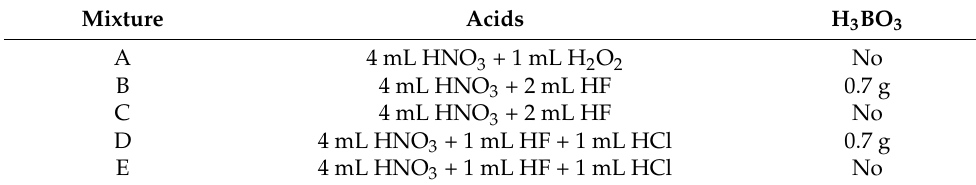
Table 6. Acid mixtures tested for microwave-assisted